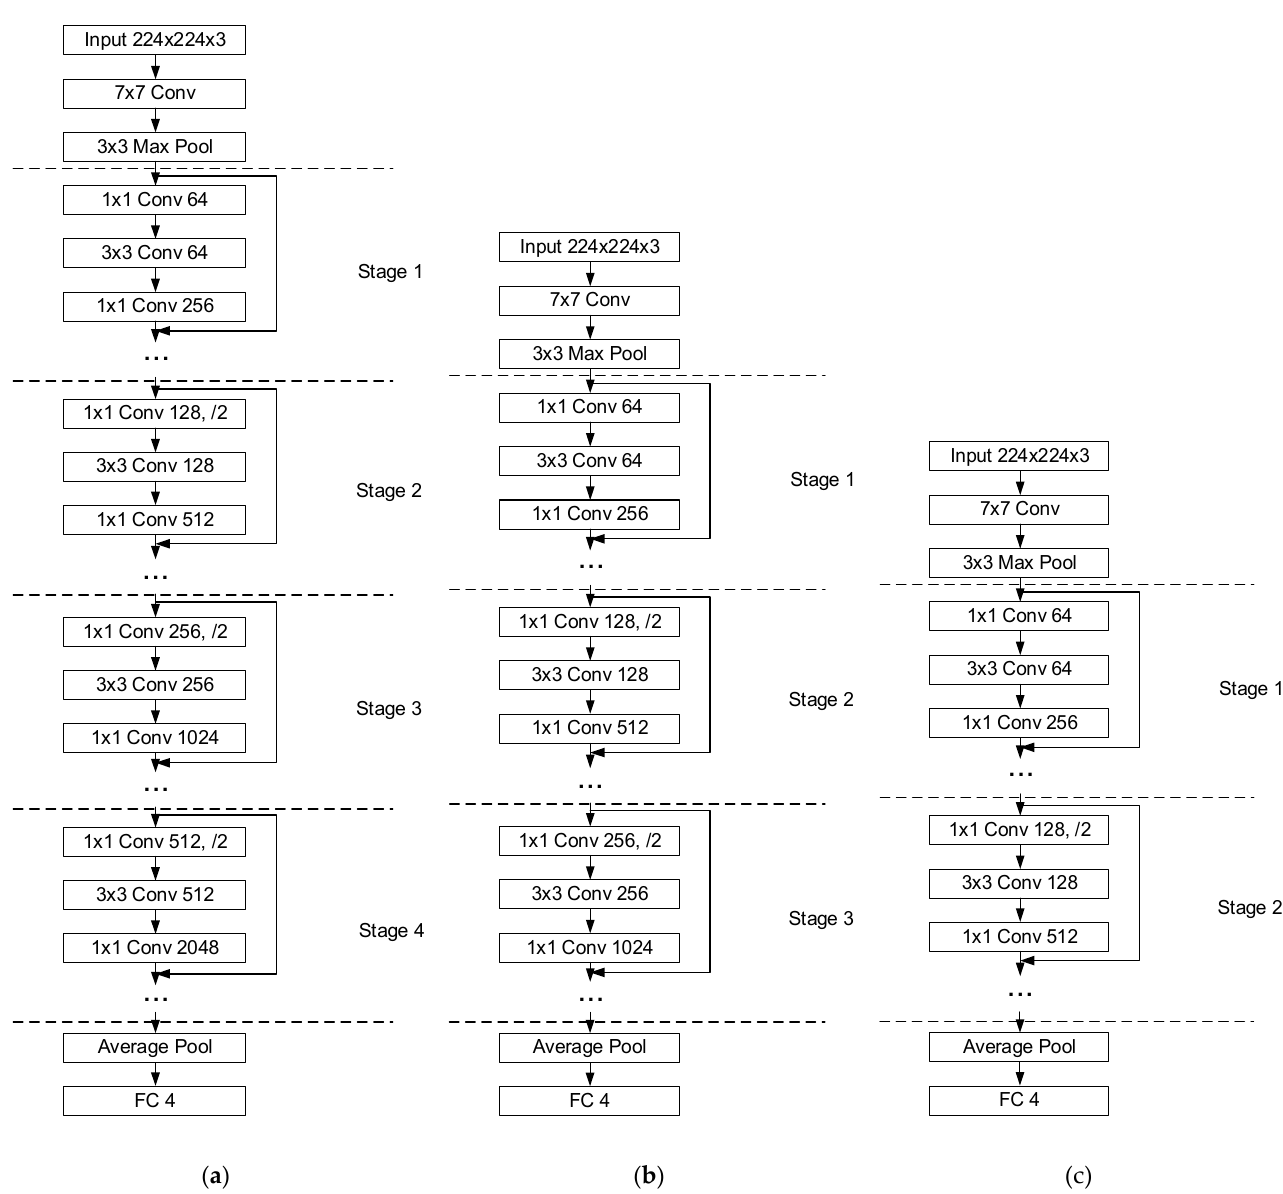
Figure 4. ( a ) Architecture of Model II; ( b ) architecture of Model III; ( c ) architecture of Model